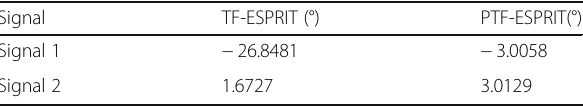
Table 1 The average value of the DOA estimates of two algorithms